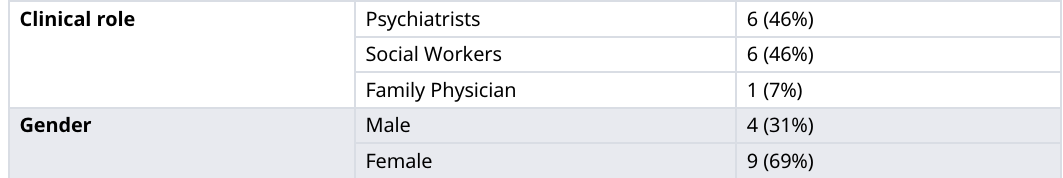
Table 1. Displays the total number and percentage of participants (n = 13) by role and